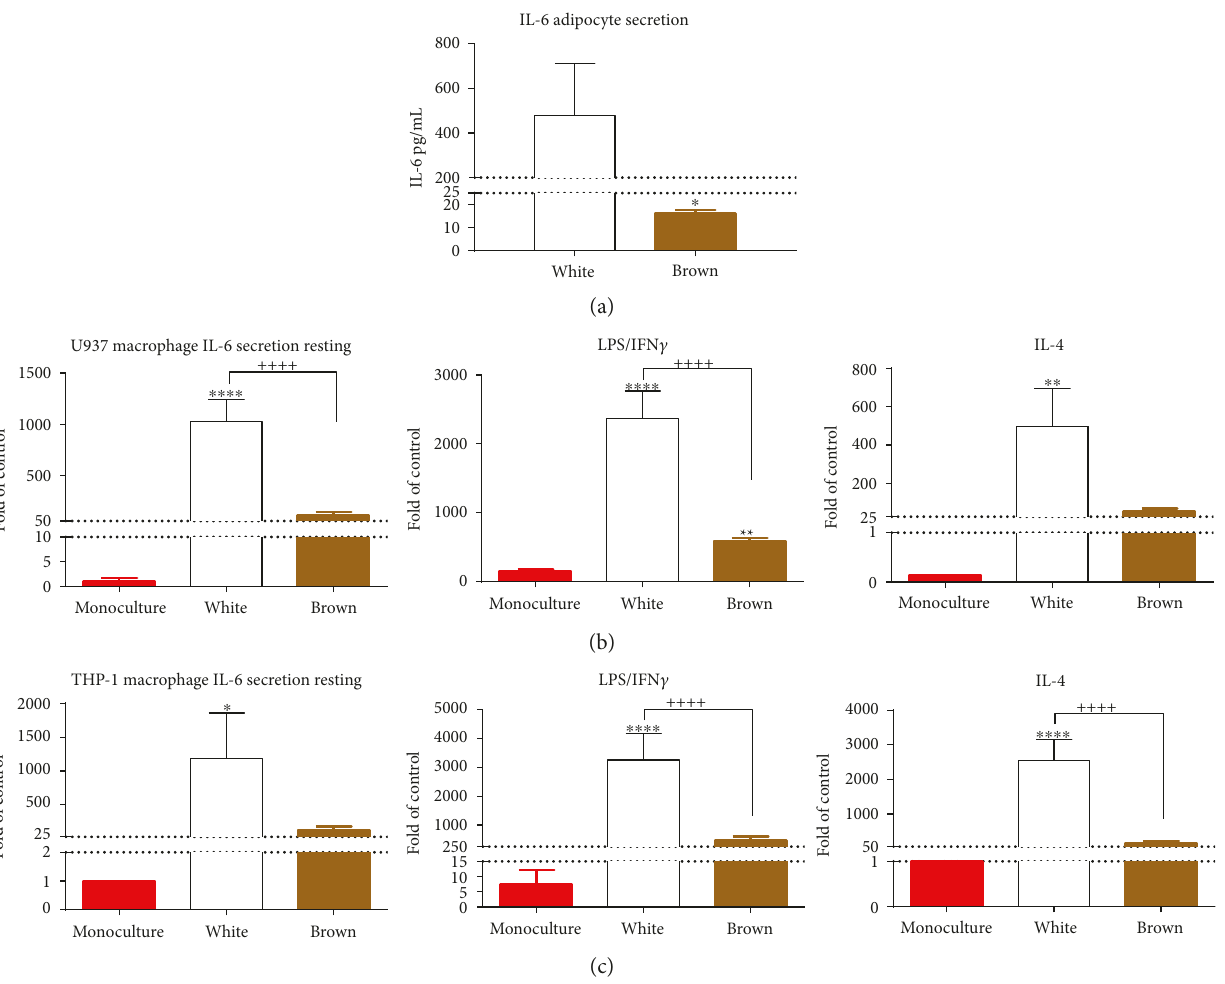
Figure 2: Di ff erential e ff ects of brown and white adipocytes on IL-6 secretion. Preadipocytes were cultured for 24 hours prior to di ff erentiation for 10 days as described in Section 2. Di ff erentiated adipocytes grown on transwell inserts were then cocultured for an additional 24 hours with di ff erentiated macrophages grown on transwell plates. After 12 days, IL-6 secretion was measured from conditioned media from adipocytes. (a) White adipocyte shows signi fi cantly more IL-6 secretion than brown adipocytes. Bar graphs represent mean +SEM of N = 4 biological replicates of the same adipocyte clone cultured in a separate well. Student ’ s t -test, ∗ p < 0 05 . After macrophages were di ff erentiated, cells were either left untreated (resting state) or treated with LPS/IFN γ or IL-4 for 24 hours. Media with stimuli were removed and cells were then washed prior to coculture with or without adipocytes that were di ff erentiated as described in Section 2. ((b) and (c)) Coculture of macrophages with white adipocytes signi fi cantly increases IL-6 secretion compared to monoculture of macrophage alone and when cocultured with brown adipocyte in both U937 (b) and THP-1 (c) macrophages in culture conditions of macrophages that were previously at rest or stimulated with LPS/IFN γ and IL-4 for 24 hours. Bar graphs represent mean+ SEM of biological replicates of cultures grown in separate wells. N = 11 for macrophage monoculture, N = 4 for macrophages cocultured with white adipocytes of the same clone, and N = 6 for macrophages cocultured with brown adipocytes of the same clone. Two-way ANOVA followed by Tukey ’ s post hoc test for multiple comparisons. ∗ p < 0 05 , ∗∗ p < 0 01 , and ∗∗∗∗ p < 0 0001 compared to monoculture. ++ p < 0 01 and ++++ p < 0 0001 white versus brown